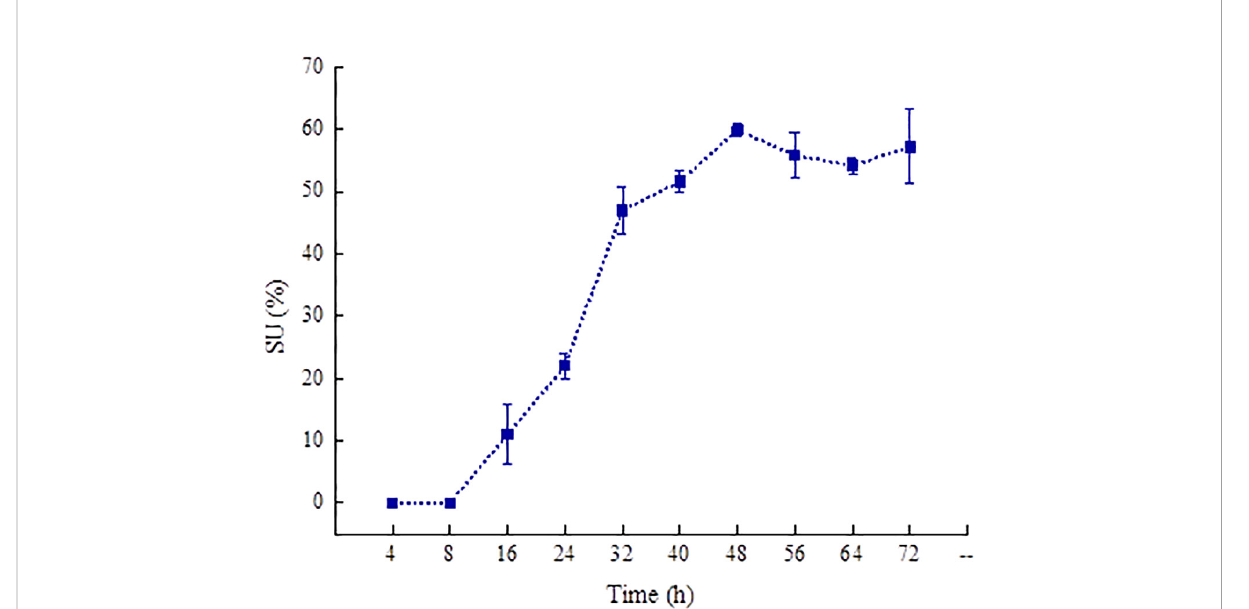
FIGURE 3 The content changes of siderophore produced in P. aeruginosa PAO1 with